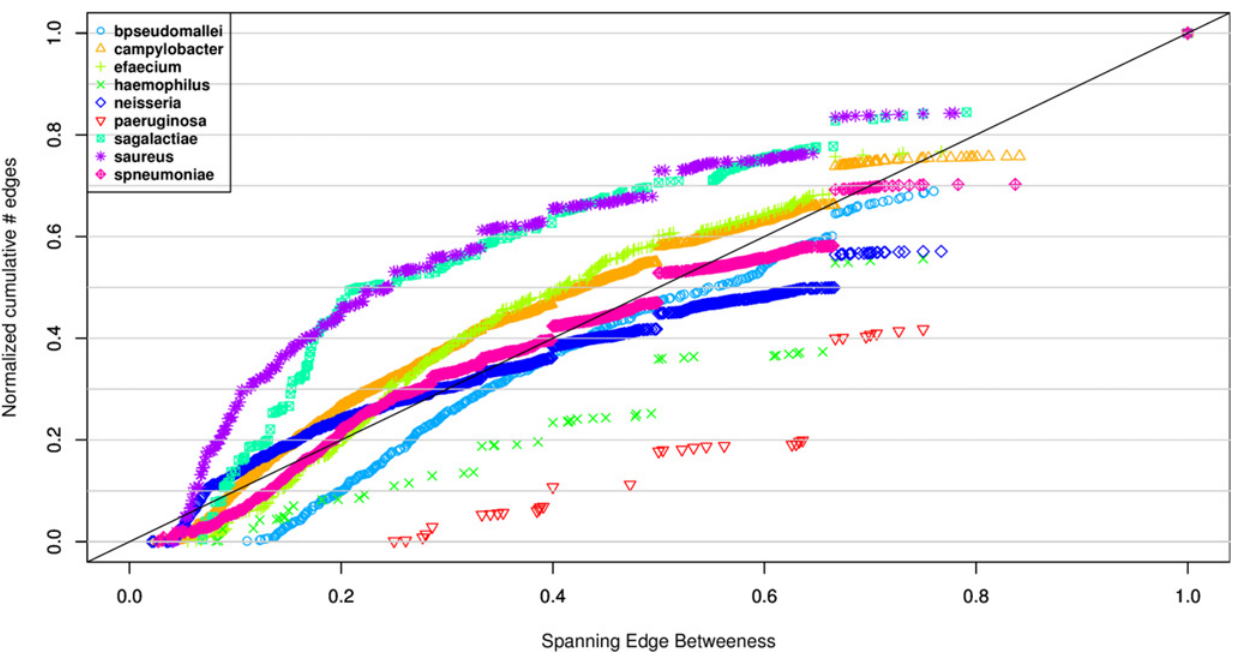
Fig 2. Cumulative spanning edge betweenness of the forest of MSTs at the SLV level selected by goeBURST for the different bacterial species. The fraction of MSTs where a given edge is present is computed for each edge, considering all CCs for each bacterial species. The plot is performed cumulatively and the number of edges normalized (for values between 0 and 1). The diagonal represents a putative case where each value of spanning edge betweenness is represented by the same number of